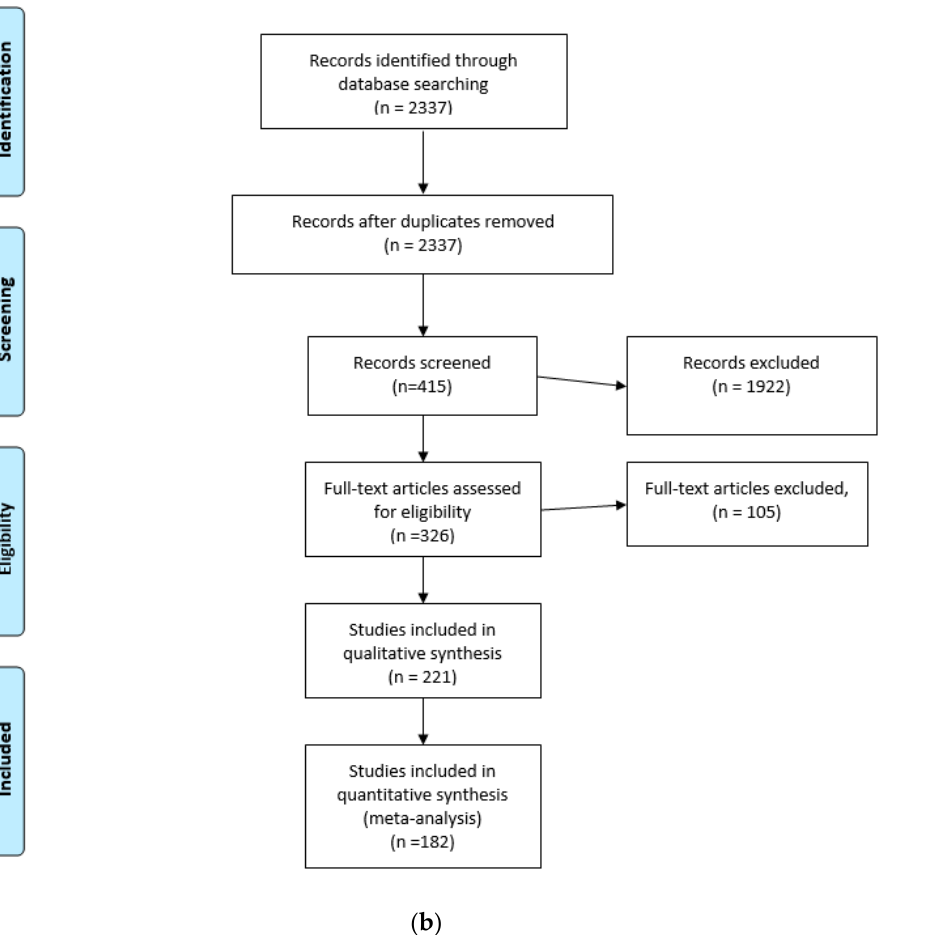
Figure 1. ( a ) PRISMA Flow Diagram for MPC. ( b ) PRISMA Flow Diagram for benign MPNs.